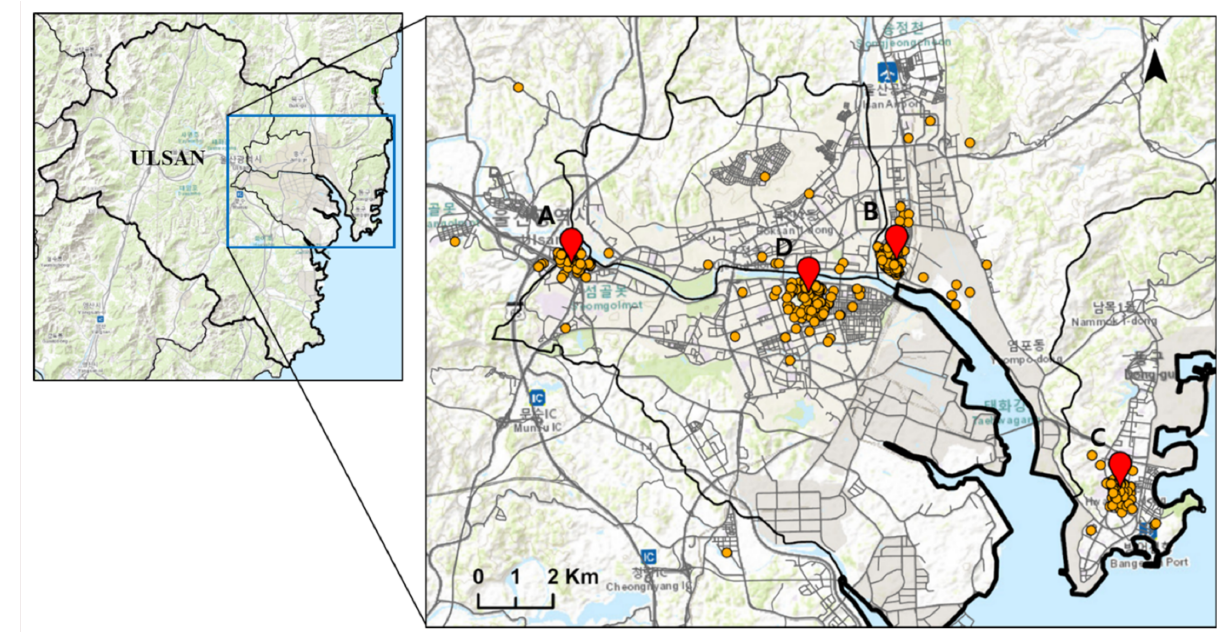
Figure 1. Location of 4 elementary schools: A, Gulhwa; B, Myeongchon; C, Yangi; D,